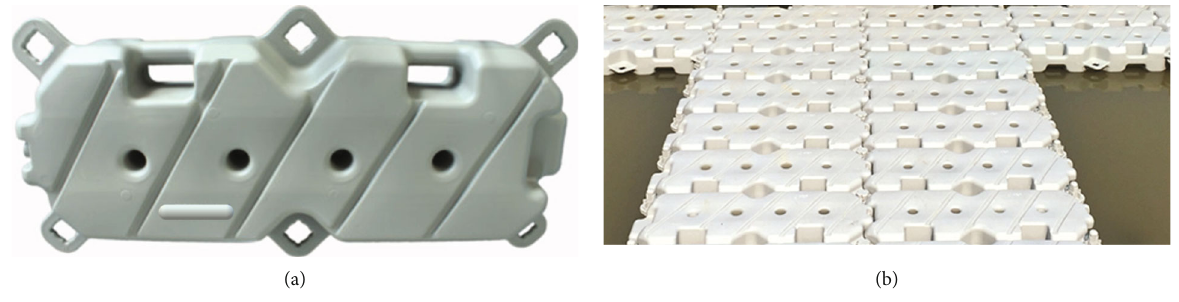
Figure 18: (a) Float module. (b) Connected modules forming